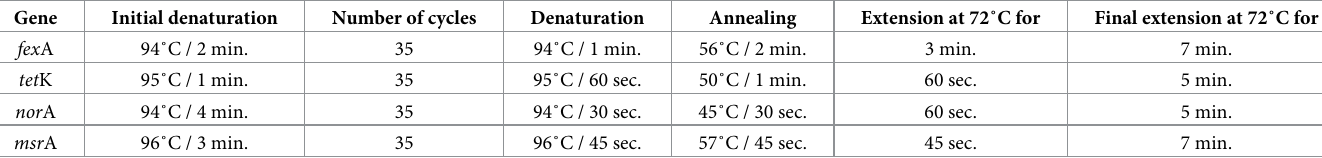
Table 2. Amplification reaction cycles of